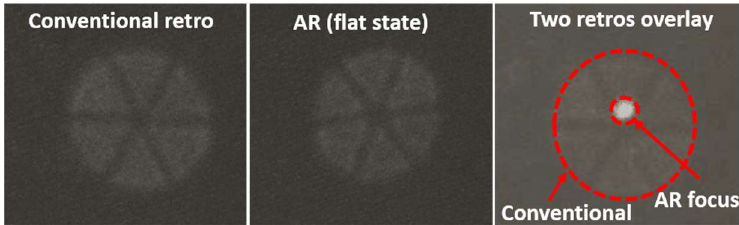
Figure 11. Images taken in the laboratory at a known distance from the retroreflector are shown ( left ) conventional retroreflector, ( middle ) AR in the flat state, and ( right ) both retroreflectors over- lapping in the screen with the AR actuated to focus the beam at that particular distance.